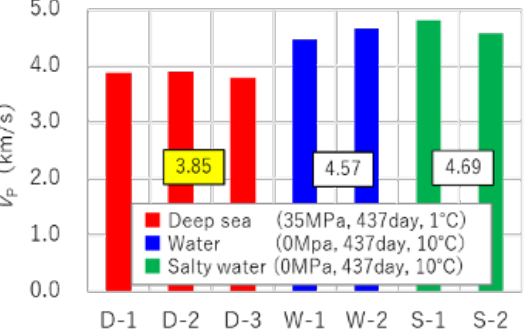
Figure 9. Ultrasound travel velocity. X-axis repre- sents the exposure conditions and number of speci- mens.